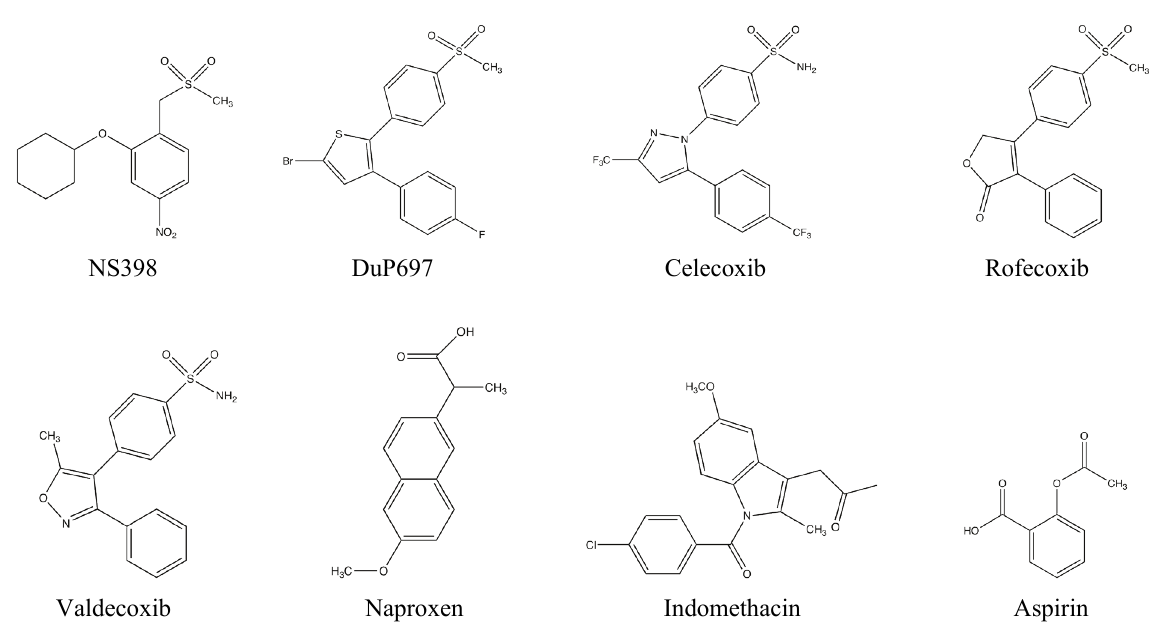
Figure 2. Chemical structures of common NSAIDs